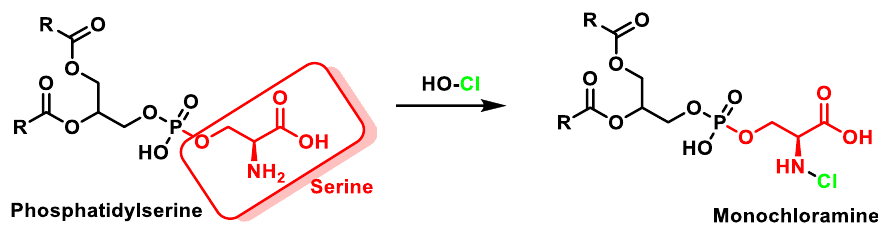
Figure 15. Formation of monochloramine from the oxidation of phosphatidylserine by HOCl.